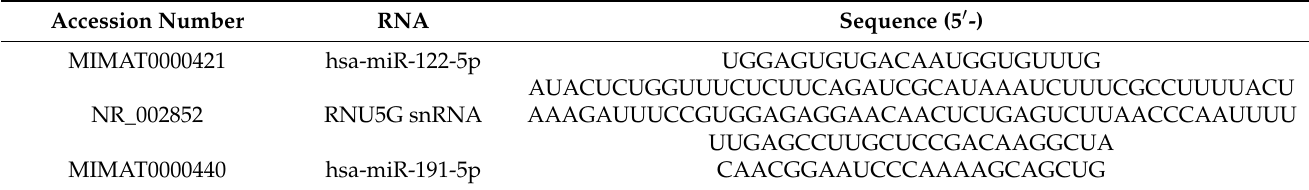
Table 2. Primer sequences for miR-122-5p, RNU5G and miR-191-5p. RNA Sequence (5 (cid:48)